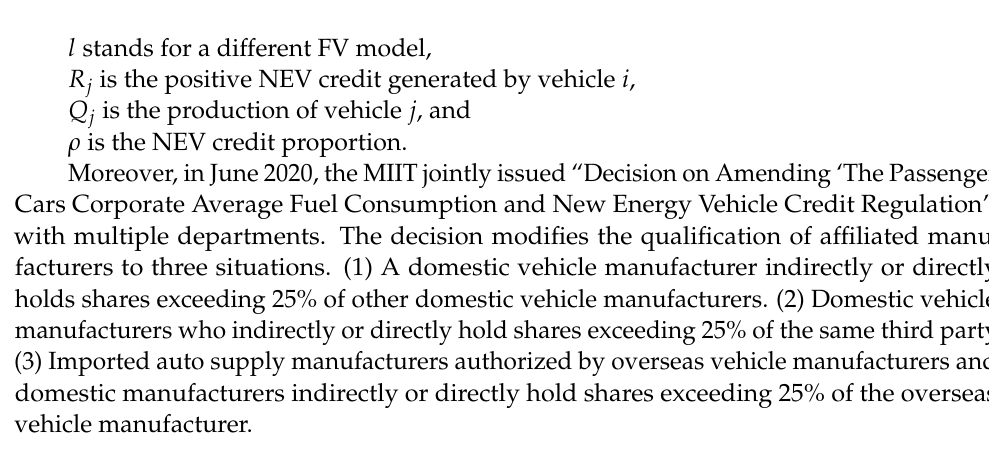
Table A1. Subsidy scheme for NEV vehicles in 2021.